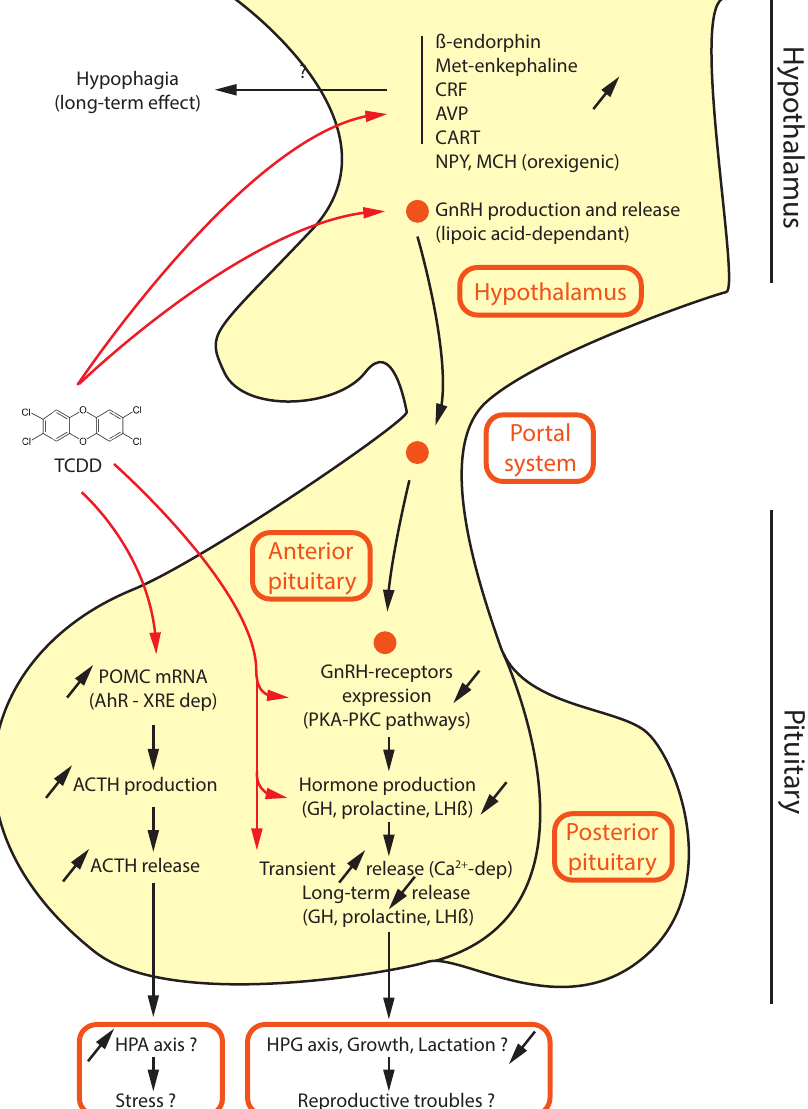
Figure 2. The putative effects of tetrachlorodibenzo-p-dioxin (TCDD) on the hypothalamic-pituitary